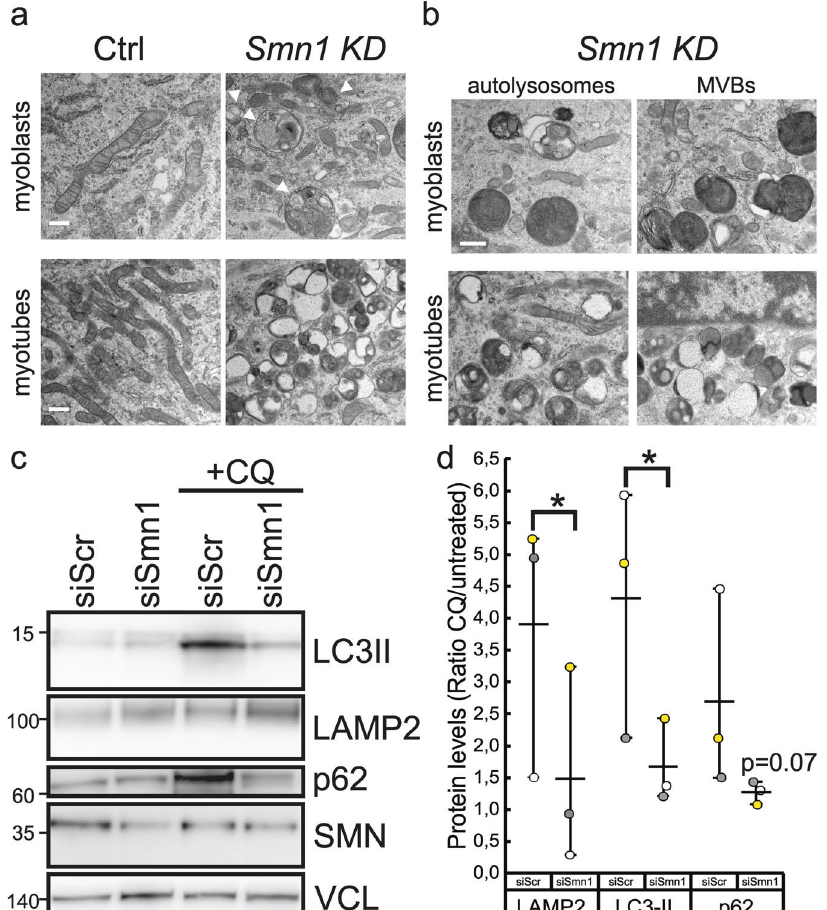
Fig. 7 Smn1 de fi cient muscle cells accumulate autolysosomes and multivescicular bodies (MVBs). a Representative electron microscopy images showing increased number of autolysosomes and MVBs (white arrows) upon Smn1 knockdown in C2C12 myoblasts and differentiated myotubes ( n = 3 independent experiments). Scale bar: 10 μ m. b Representative high magni fi cation of Smn1 de fi cient muscle cells. Scale bar: 500 nm. c Equal amounts of siScr and siSmn1 transfected C2C12 lysates (20 µg) were separated by SDS-PAGE and immunoblotted using the indicated antibodies. Where indicated the cells were treated with chloroquine (CQ) before collection. d Dots plot of the differences in the amount of LAMP2, LC3-II and p62 between samples in the presence and absence of CQ as a measure of the autophagic fl ux in siScr and siSmn1 transfected cells ( n = 3 paired biological replicates represented by different colors). p value was calculated using ratio paired t test one tail statistical analysis; LAMP2 and LC3-II, * p = 0.04; p62, p =